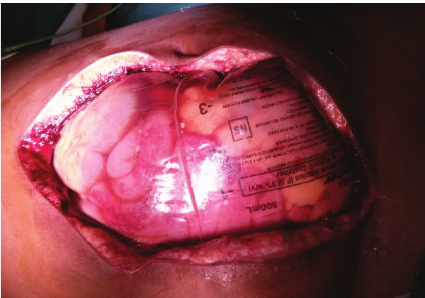
Figure 4: Shows Laparotomy wound which was packed because of massive bowel edema.